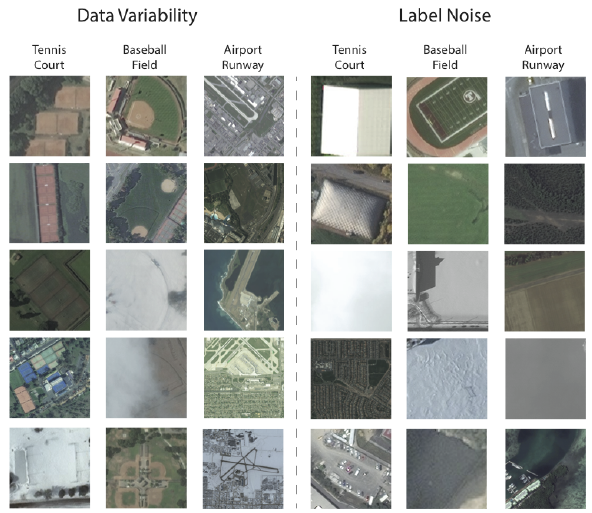
Figure 2: a - Example instances from three of the considered classes are shown to represent the appearance variability present in the training data. b - Example instances of wrongly labeled training points in the OSM database are shown to give a sense of the label-quality of the training data.